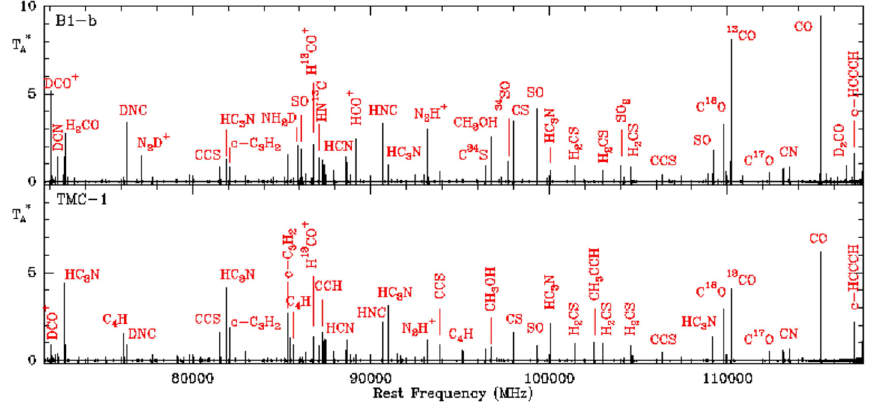
Table 1. Identified molecules within the 3mm line